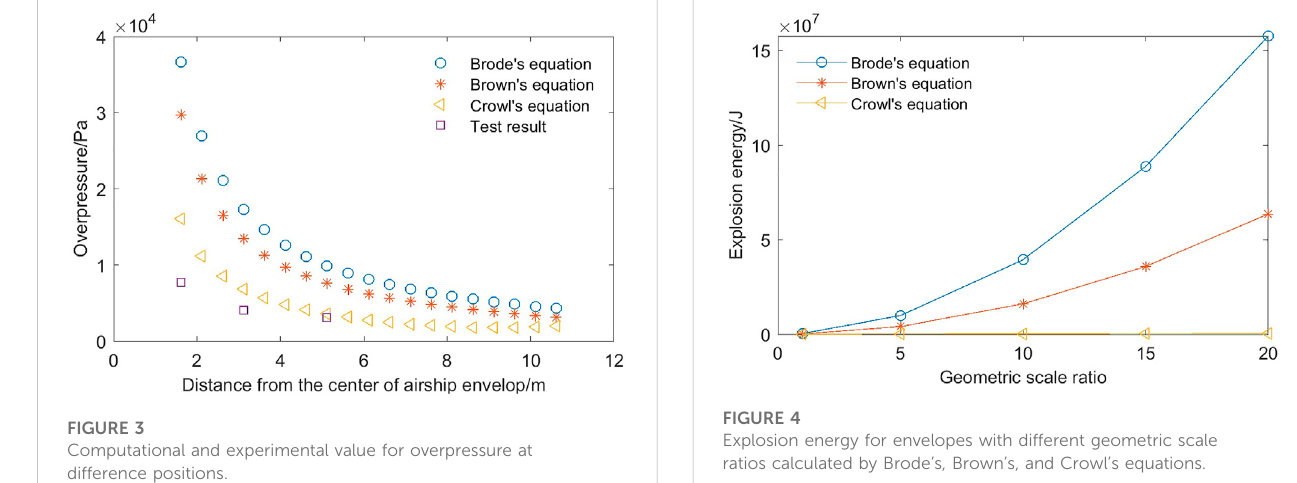
TABLE 3 Computational and experimental value for overpressure at three positions. Distance from the center of the airship envelope (m)